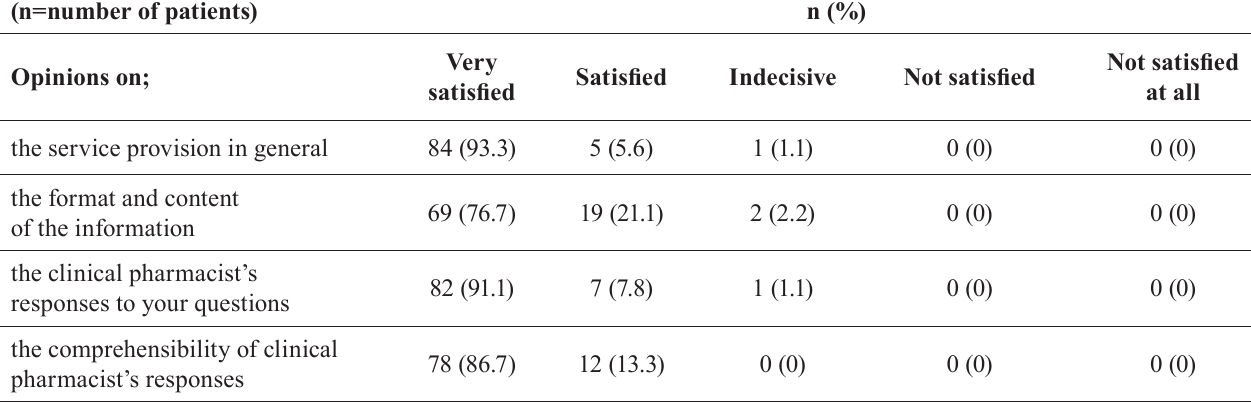
TABLE V - P atient satisfaction about drug information provided by a clinical pharmacist